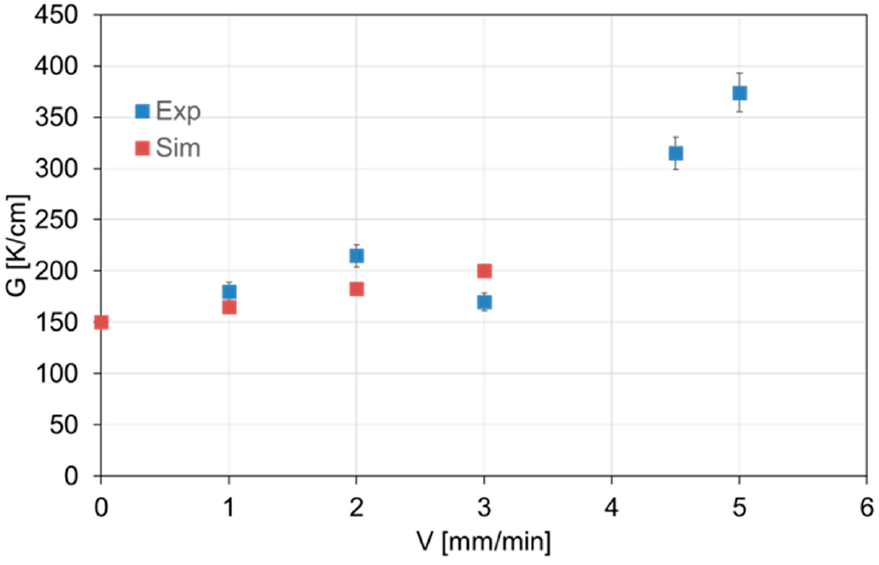
Figure 7. Temperature gradient G determined experimentally from the central facet geometry and melting isotherm and from numerical simulations as a function of the growth velocity. Figure 8 shows the diameter of the central facet along the growth direction for two <111>-oriented silicon crystals grown at a translation rate of V = 3 mm/min. One crystal was considered to be dislocation-free because it was grown with Dash-neck by the Floating Zone technique. The other was grown by the Zone Melting method without Dash-neck and thus contained dislocations. As expected (see Section 2), the diameter of the central facet of around 5 mm in most part of the dislocation-free sample is much larger than in the dislocation-containing one, where it is only 2 mm. The peak, which occurs in both crystals at the last crystal portion, is the result of a sudden increase in the growth velocity accompanied by a strong increase in the temperature gradient during the solidification of the final molten